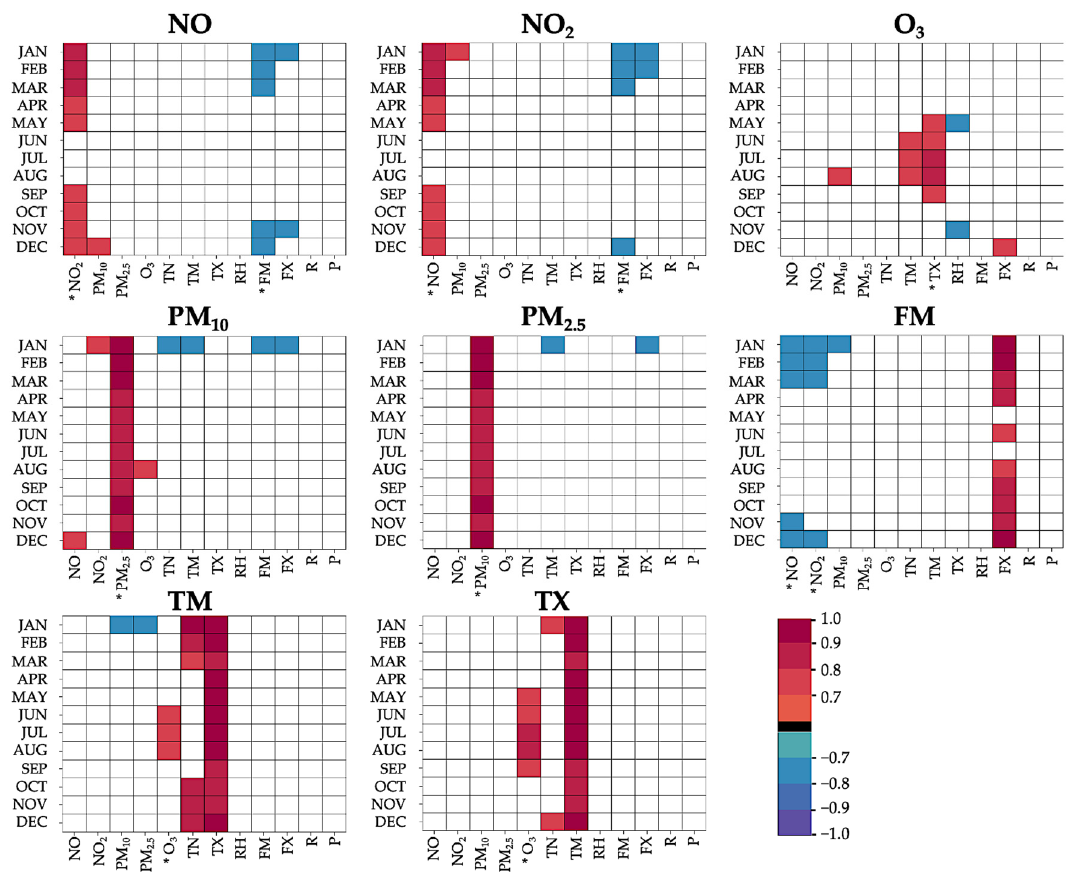
Figure 2. Monthly predictor correlation coefficients for all predictors with respect to the case-crossover analysis. Only coefficients >0.7 and < − 0.7 (=shared variance approx. 50%) were plotted. Variables for which case-control was necessary are marked with *.